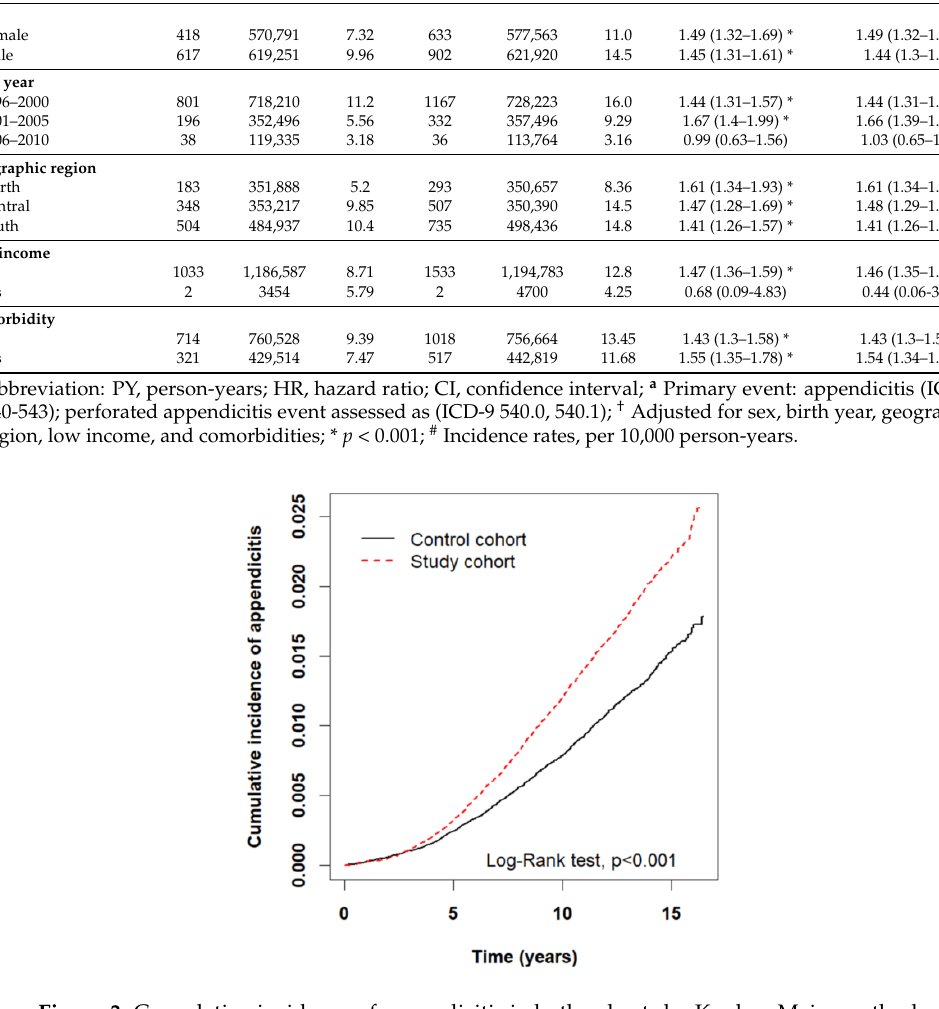
Figure 3. Cumulative incidence of appendicitis in both cohorts by Kaplan – Meier method.